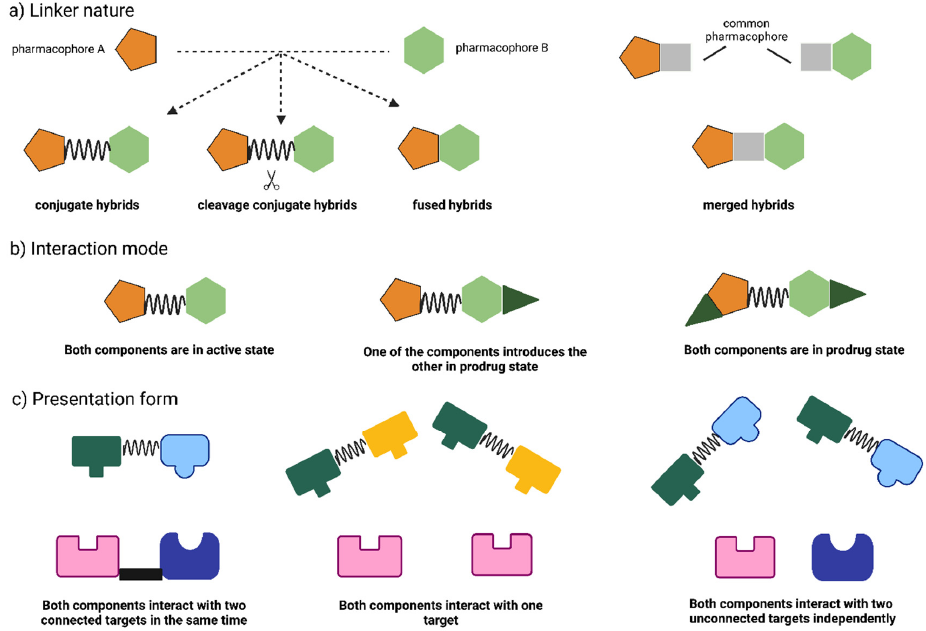
Figure 1. The classification of hybrid compounds is based on: ( a ) The nature of the linker used; ( b ) The mode of the interaction of each pharmacophore with targets; ( c ) The form of presentation.